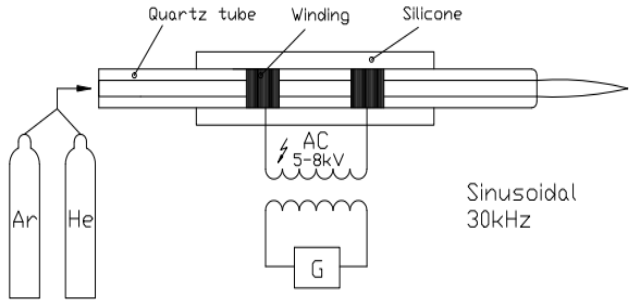
Figure 2. Bespoke rig for cold atmospheric plasma activation.